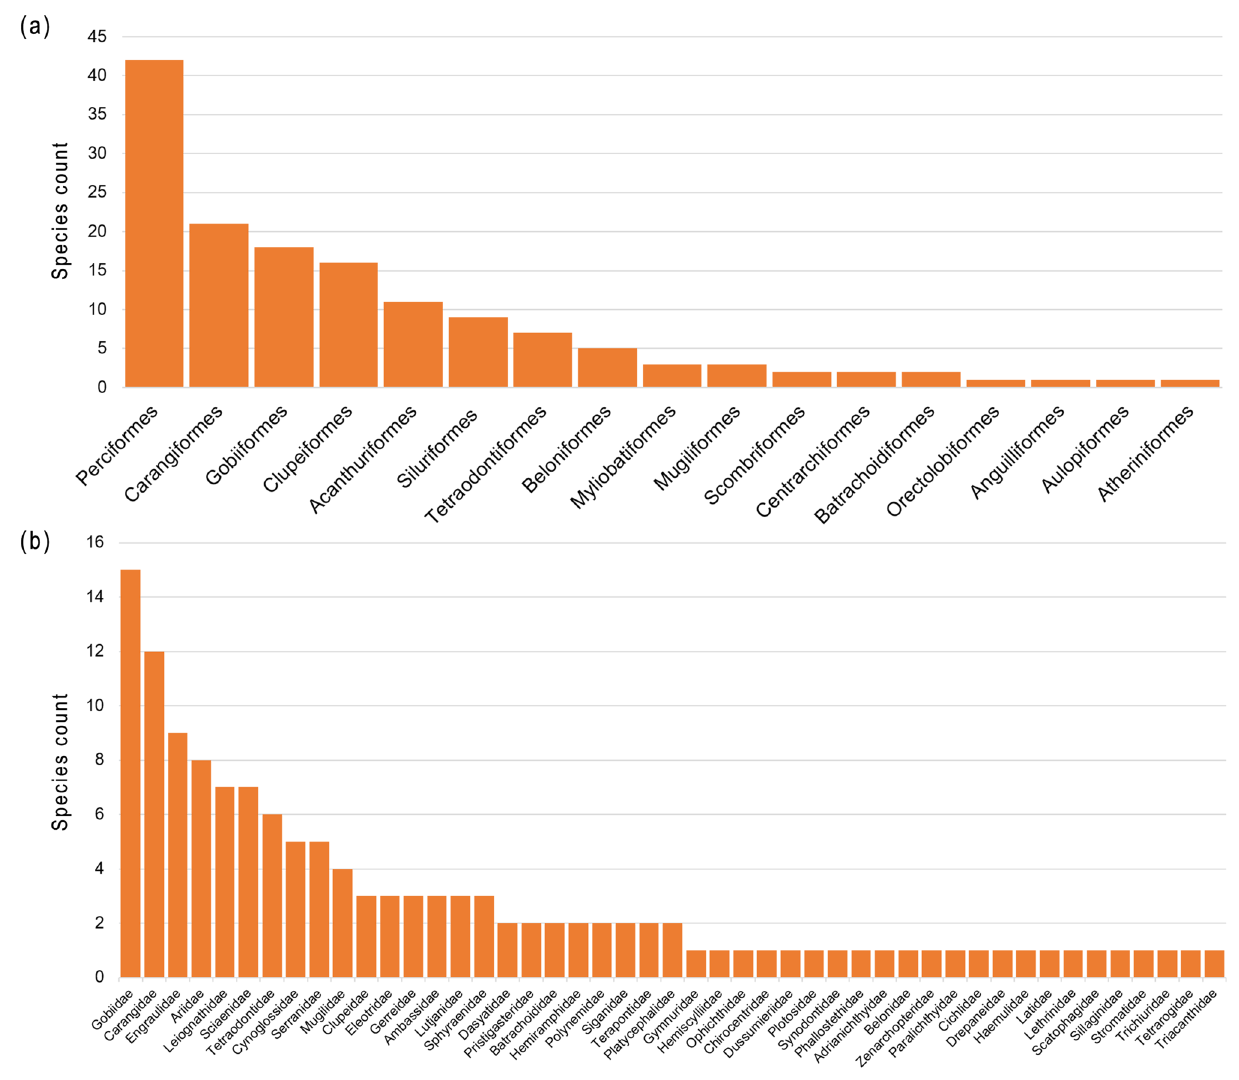
Figure 2. Species count rankings according to ( a ) orders and ( b ) families recorded in this study. Category n Taxa Comparisons Minimum (%) Mean (%) Maximum (%) SE (%) Within species 285 75